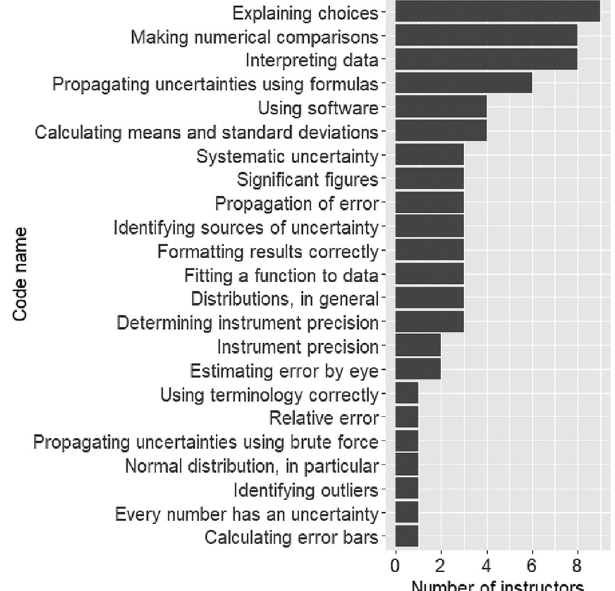
¼ 22 ) in which in- FIG. 7. The number of interviews ( N tot structors mentioned ways of assessing measurement uncertainty, broken down by the emergent codes in Tables IV and V.